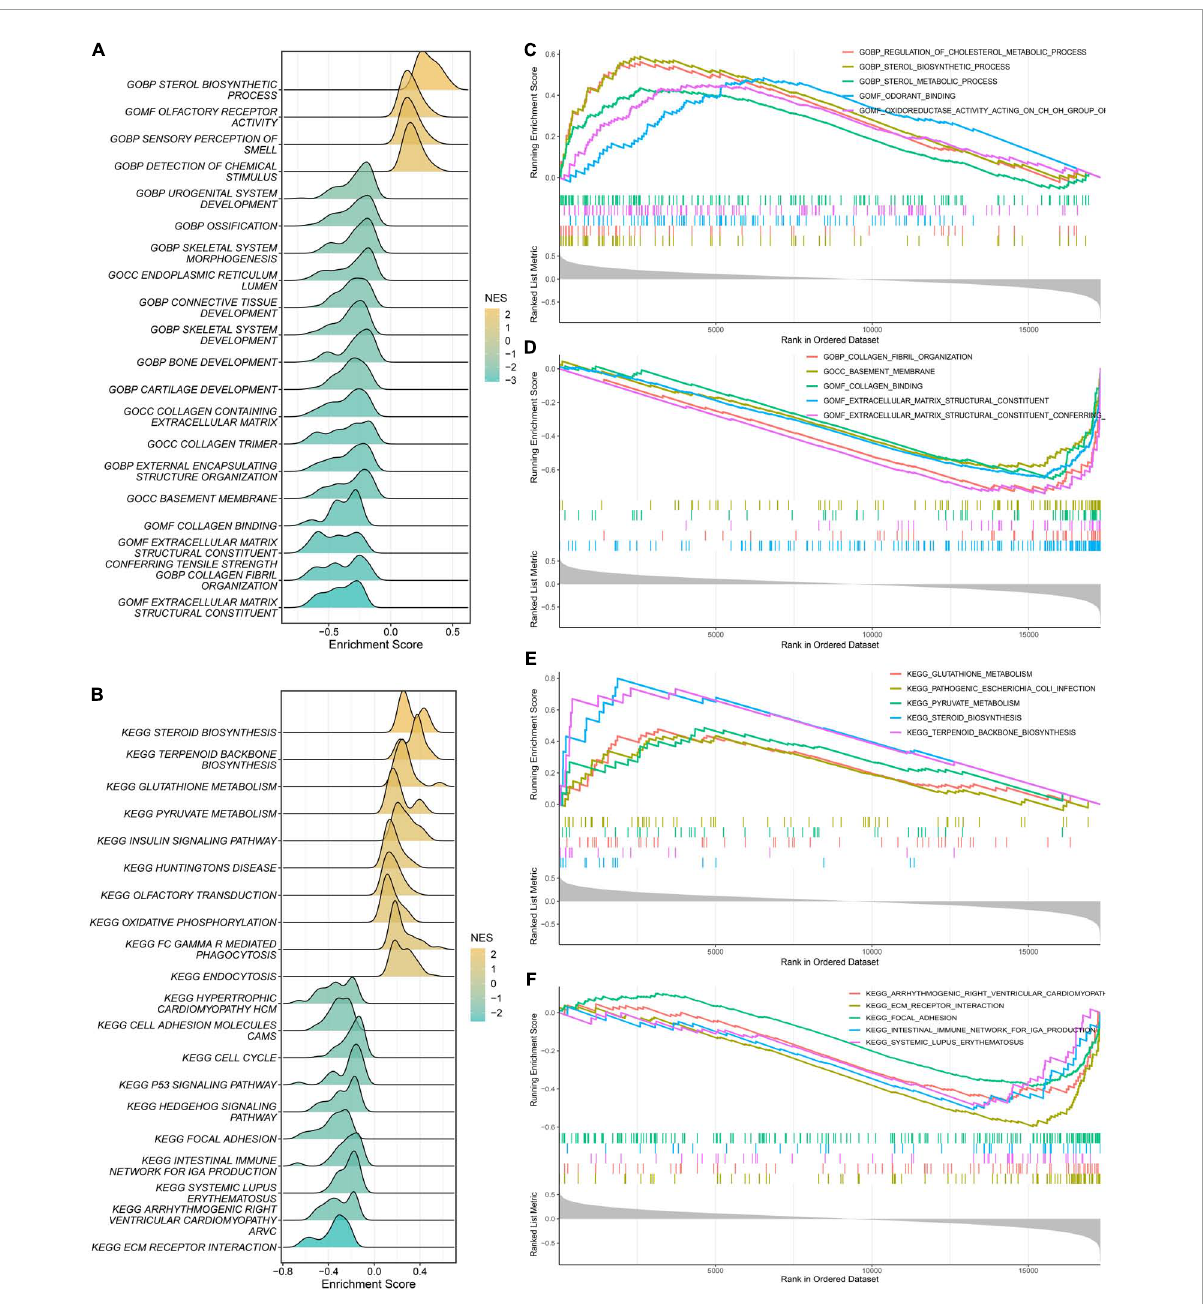
FIGURE7 Gene Set Enrichment Analysis (GSEA). (A) The ridge plot of the top 20 GO terms with ranked genes of the modeling dataset. (B) The ridge plot of the top 20 KEGG pathways with ranked genes of the modeling dataset. (C,D) The positive and negative top five GO terms with ranked genes of the modeling dataset. (E,F) The positive and negative top five KEGG pathways with ranked genes of the modeling dataset.